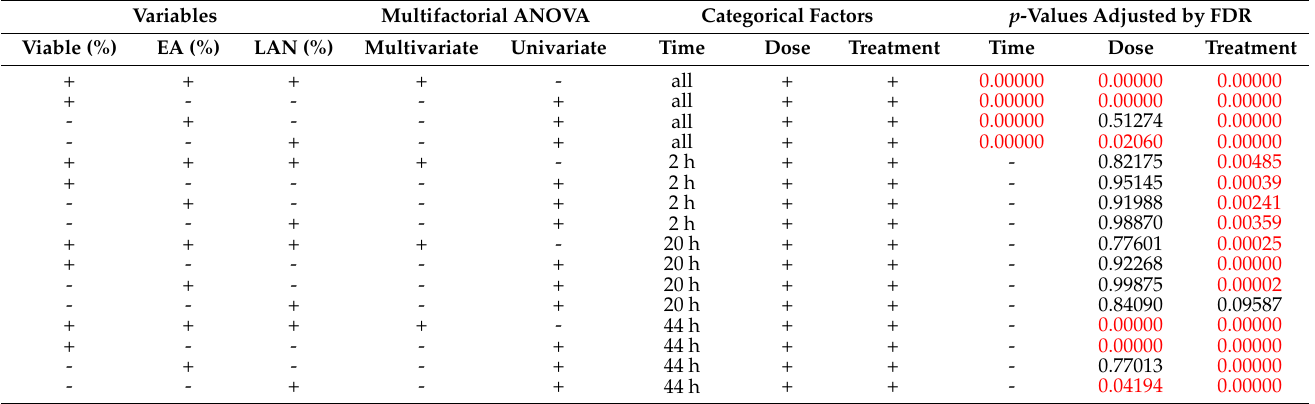
Table 2. Statistical testing dependence of all apoptotic endpoints on categorical factors: radiation dose (dose) and cal A/DMSO treatments (treatment) 2, 20, and 44 h